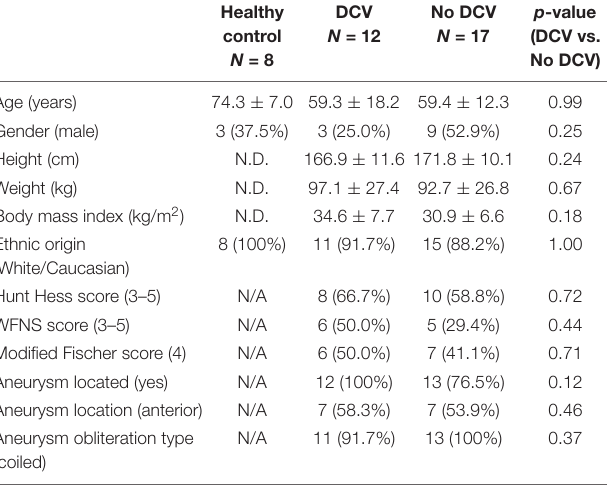
TABLE 1 | Demographic and statistics of the study